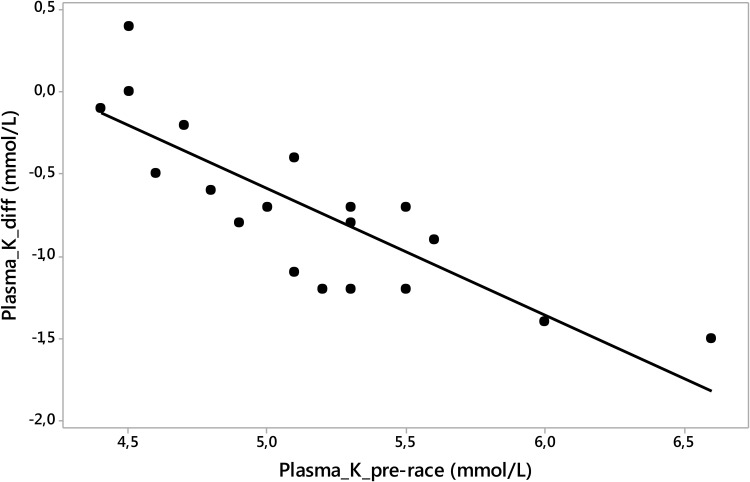
Pre-race plasma [K+] was negatively associated with plasma [K+] change post-race (p = –0.85, p < 0.001). Plasma_K_pre-race, plasma potassium pre-race; plasma_K_diff, plasma potassium difference post- minus pre- race value.